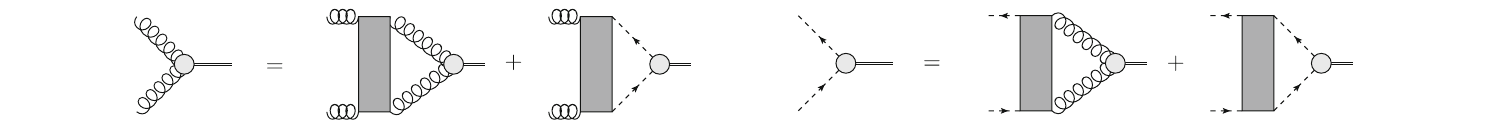
Fig. 1 The coupled set of BSEs for a glueball made from two glu- ons and a pair of Faddeev–Popov (anti-)ghosts. Wiggly lines denote dressed gluon propagators, dashed lines denote dressed ghost propaga-